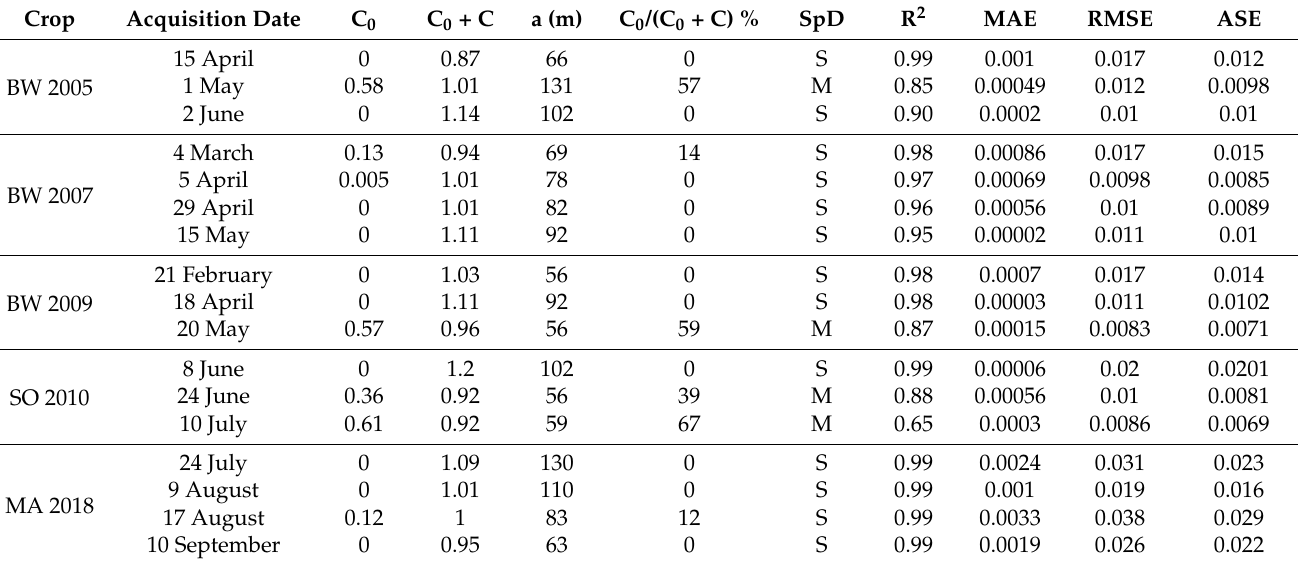
Table 11. Semi-variogram analysis of NDVI index and best fit exponential model